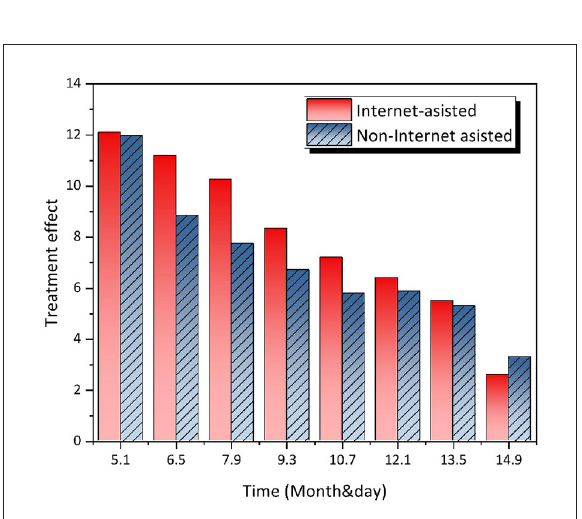
FIGURE7 Internet social participation of the elderly living alone.